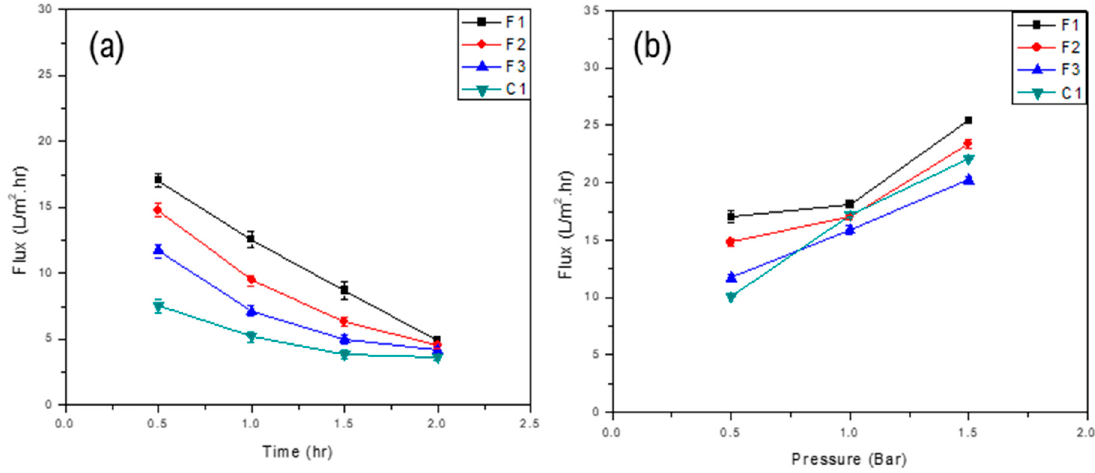
Figure 7. Flux of F ‐ type membranes as a function of ( a ) time and ( b ) transmembrane pressure. Figure 7. Flux of F-type membranes as a function of ( a ) time and ( b ) transmembrane